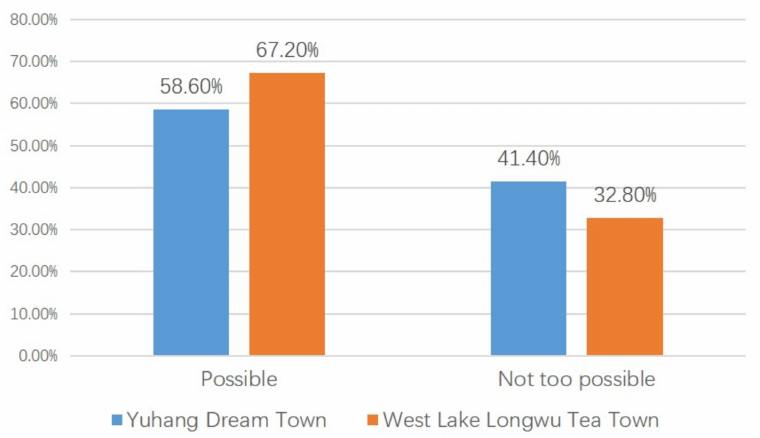
Figure 30. Possibility of establishing friendship between respondents and migrant workers (source: authors).